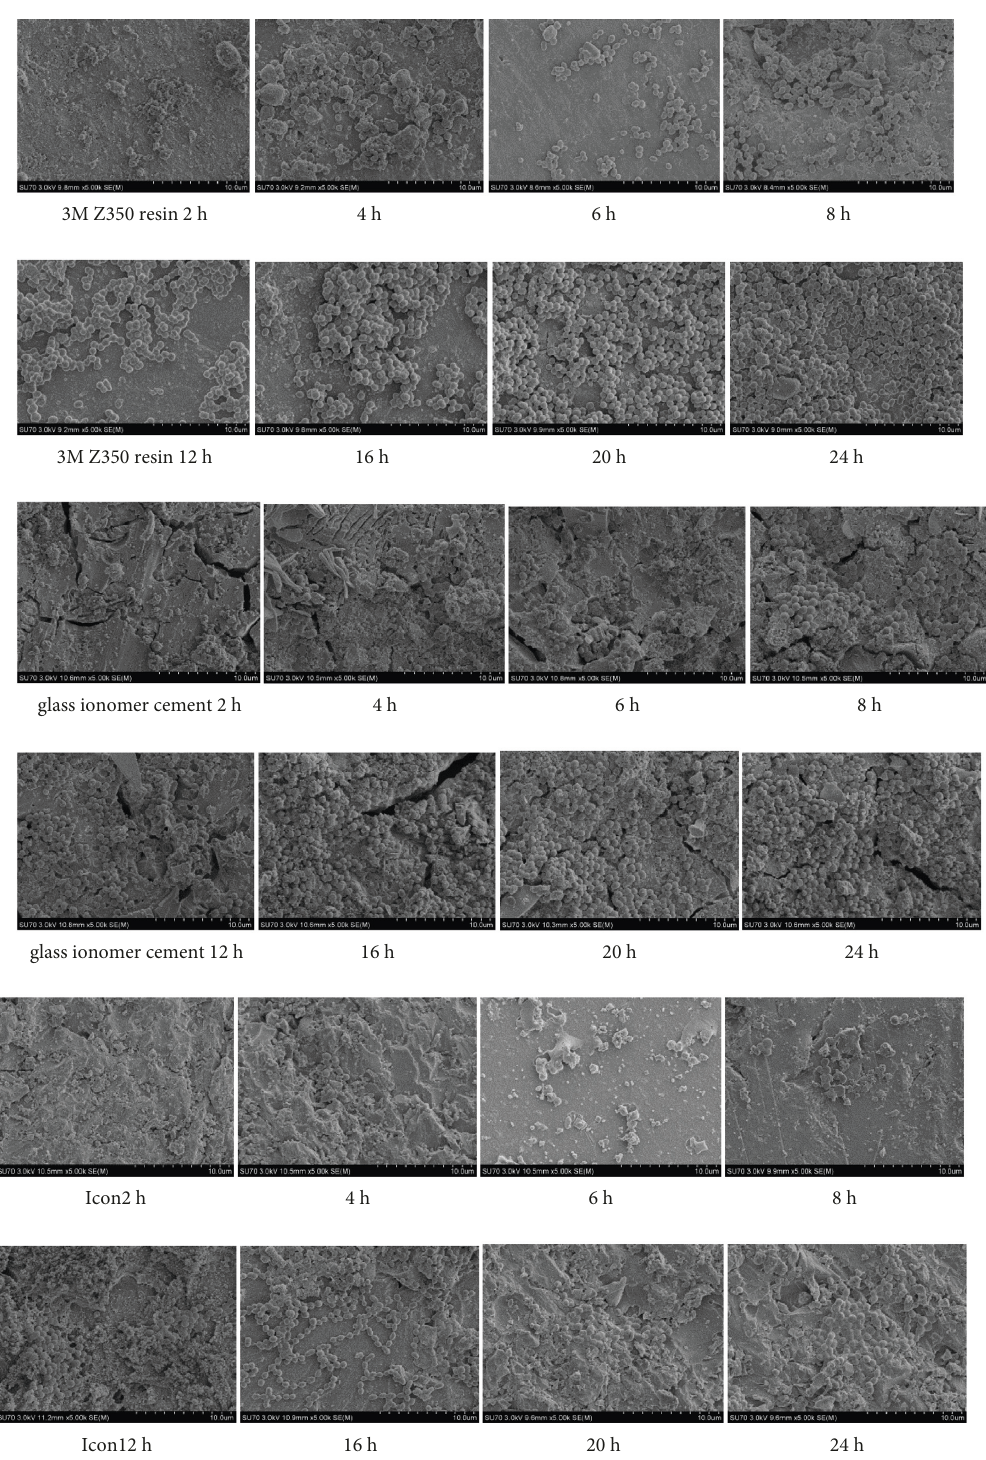
Figure 3: Electron microscopy pictures of the Streptococcus mutans